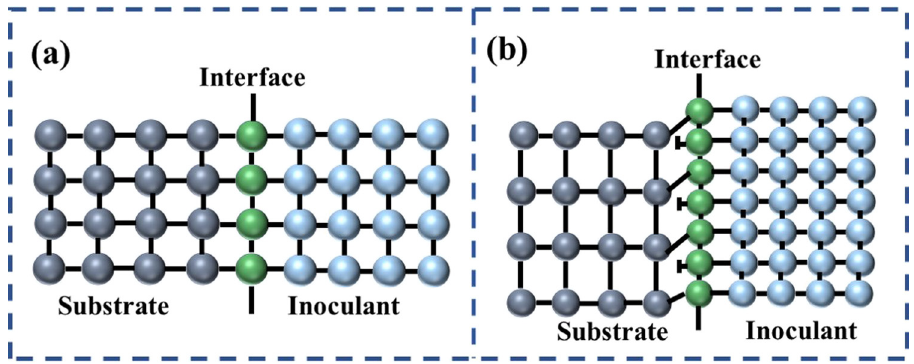
Figure 7: Schematic diagram of lattice matching between the base alloy and the wetting agent. ( a ) Coherent interface ( b ) semi - coherent